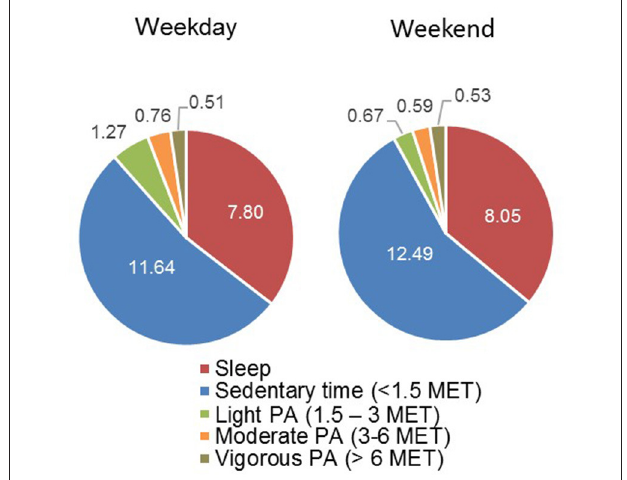
FIGURE 2 | Fraction of mean sedentary time [hours], light, moderate, and vigorous PA as well as sleep of total wear time during off-training